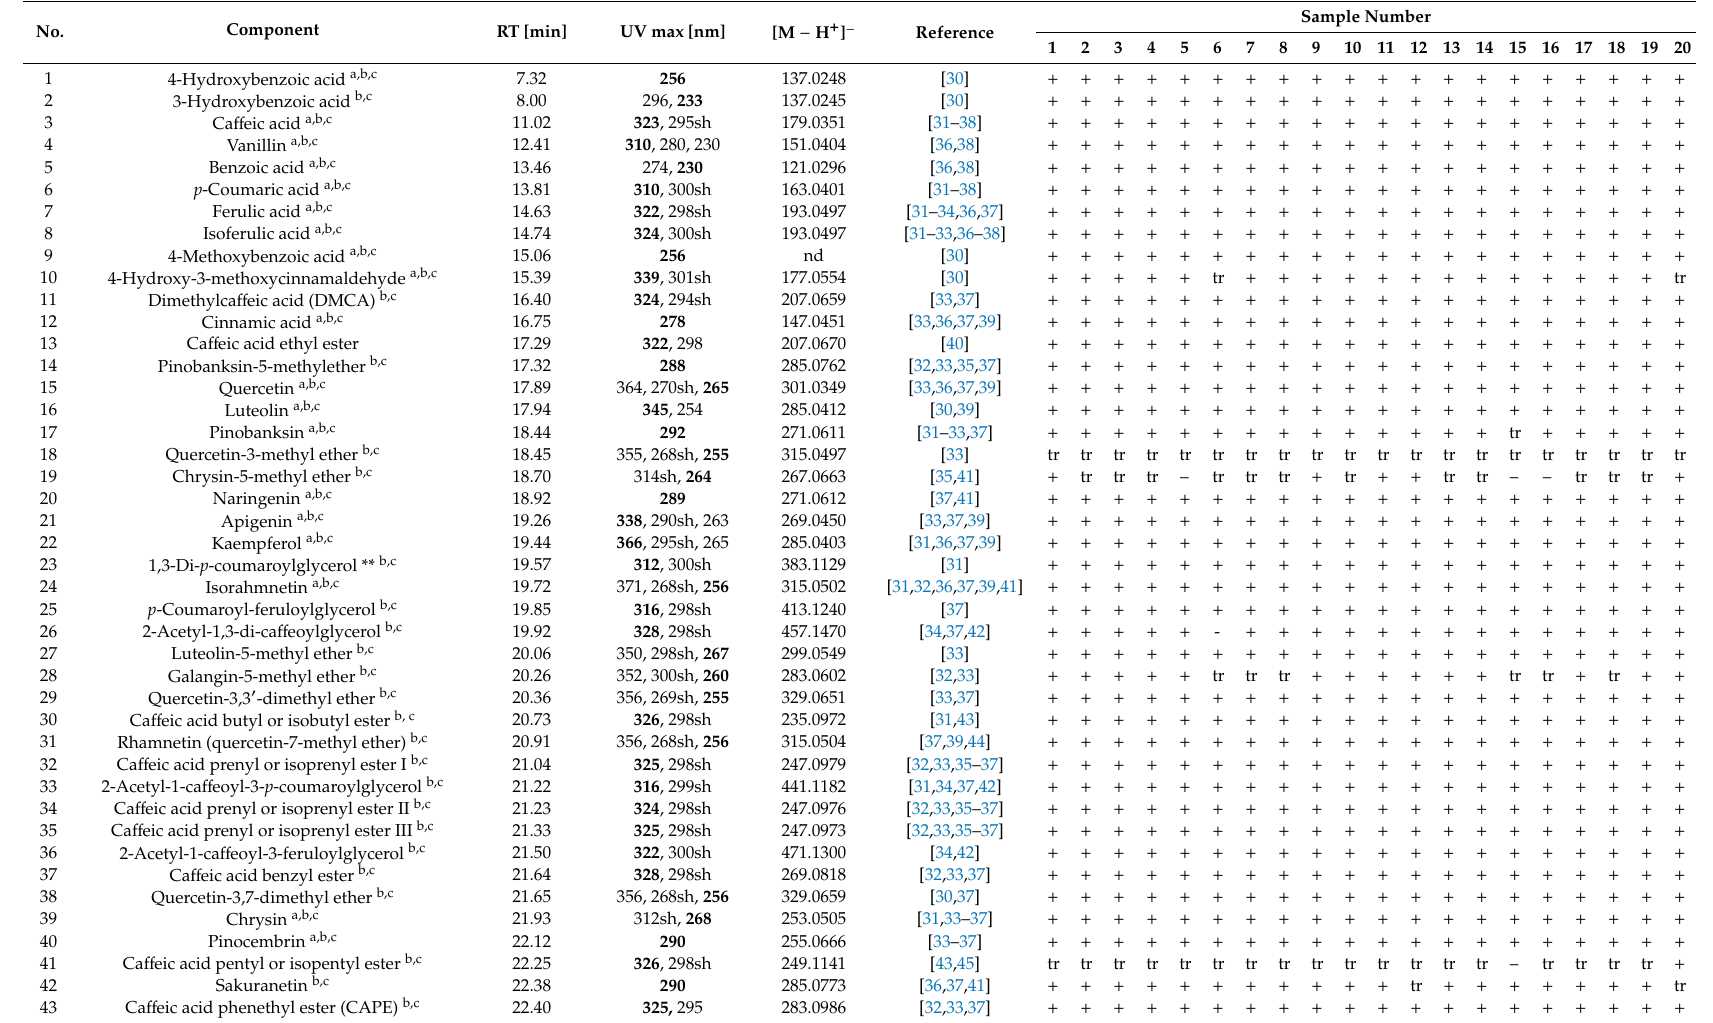
Table 5. Compounds identified in propolis samples by